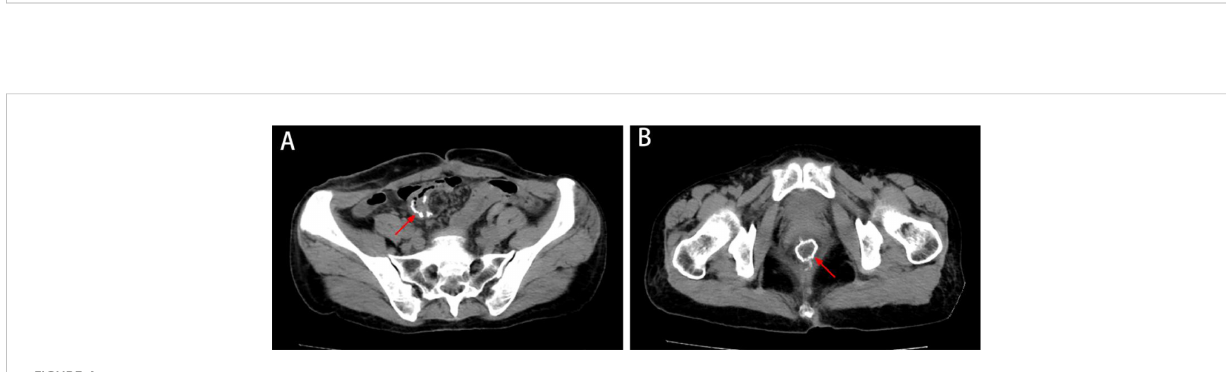
FIGURE 4 The latest imaging data. (A, B) CT showed no metastatic disease or local progression, and the anastomosis healed well (white